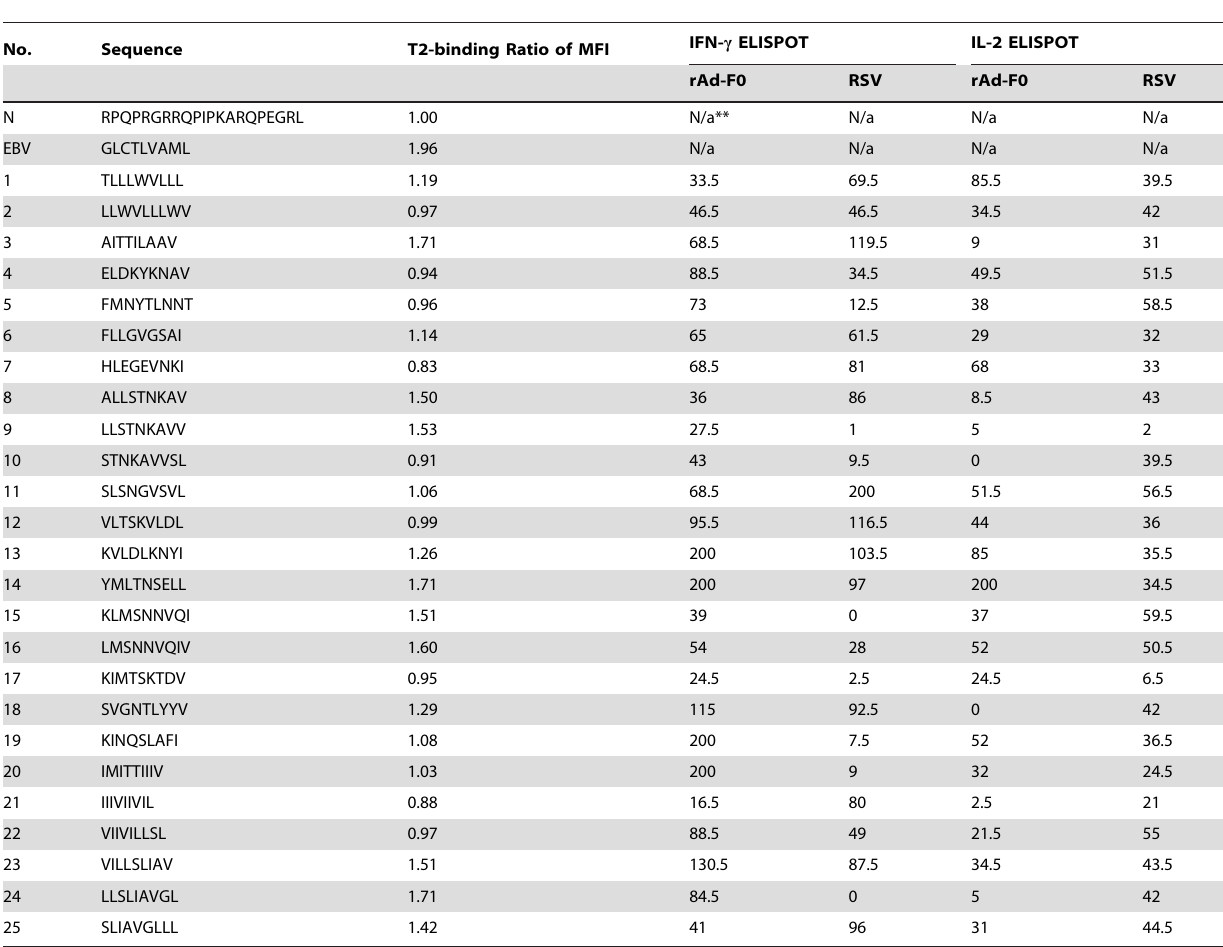
Table 1. Characteristics of HLA-A*0201-restricted epitopes of peptide spanning RSV F